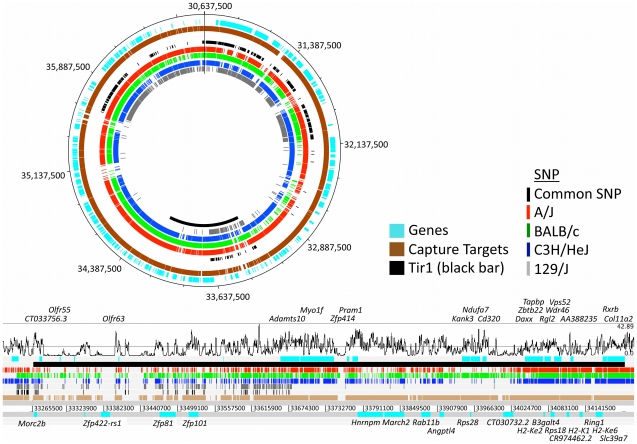
Array-based sequence capture and next generation sequencing of a 6.2 Mbp region of Mmu17 in four breeds of mice: A/J; BALB/c; C3H/HeJ and 129/J (Mmu17:30,637,692–36,837,814 bp).Plot is circular for ease of display [56]. Tir1 is highlighted in black on the inside track. Genomic positions are in Mbp. The outer tracks (blue and brown) show genes and designed capture probes, respectively. The four, coloured, inner tracks show SNP called in each of the four sequencing experiments, with the black tick marks highlighting areas of common SNP. Haplotype blocks can clearly be seen as clustering of high- and low- density regions of SNP. A magnified region around Tir1 is displayed underneath the circular plot. Tracks are identically coloured and include a moving average (window 1 Kbp) of sequence read coverage across the region (top). Genes in the region are displayed for the forward strand (above) and reverse strand (below).